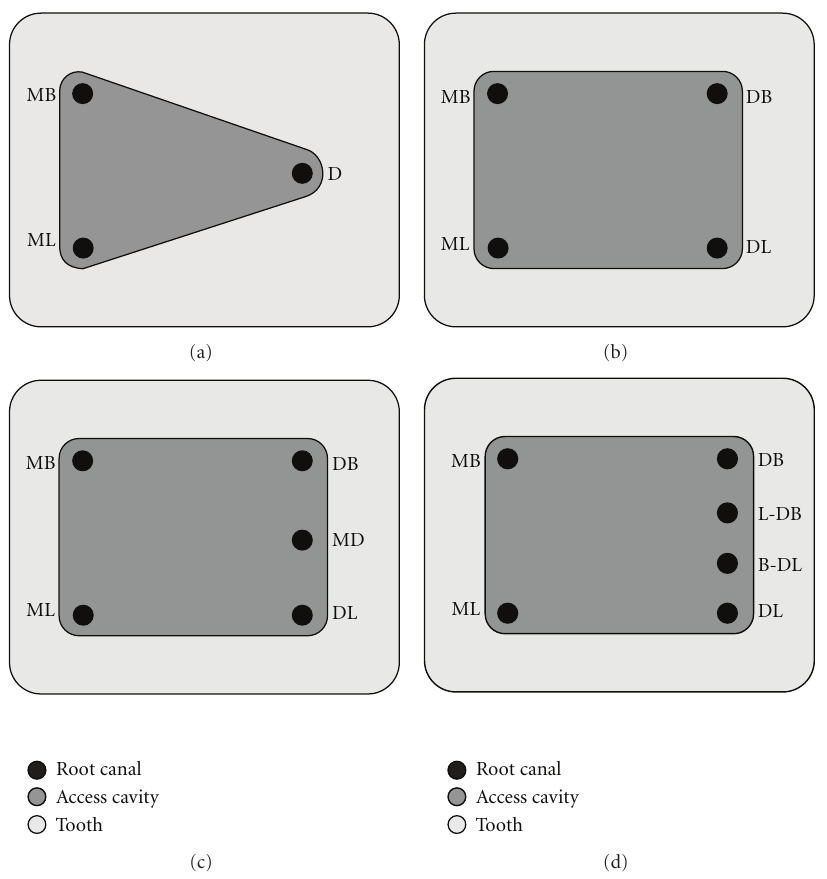
Figure 1: Diagrammatic representation of the pulpal floor in mandibular molars, illustrating the names of di ff erent canal configurations, according to the proposed nomenclature. The principle canals are named in accordance with the traditional approach in (a), as MB—mesiobuccal, ML—mesiolingual, and D—distal, or in (b) as MB—mesiobuccal, ML—mesiolingual, DB—distobuccal, and DL— distolingual. (c) An additional canal located in the distal root between the two principle canals is named as middle distal, MD. (d), Two additional canals located in the distal root are named as linguo-distobuccal (L-DB) and bucco-distolingual